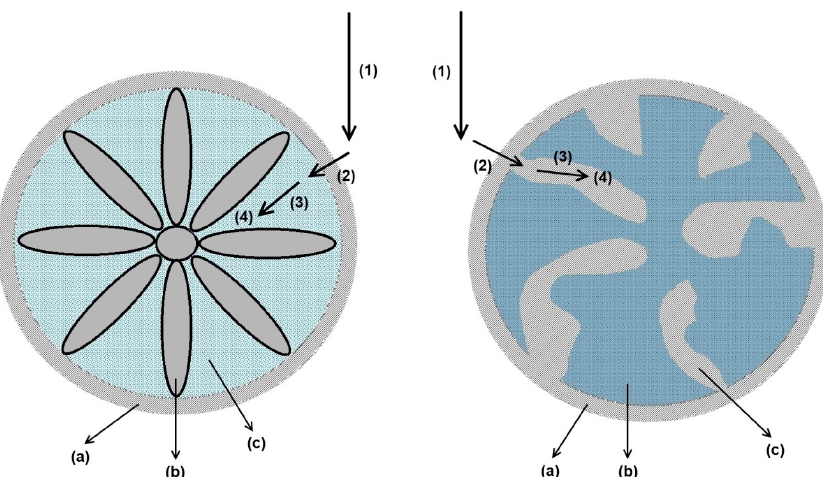
Figure 2. Comparision between mass-transport mechanisms for modified winged fibers ( left ); and porous resins ( right ). (1) Convective transport in mobile phase; (2) External film diffusion; (3) Hydrogel/Pore diffusion; (4) Adsorption. (a) External film; (b) Solid support matrix; (c) Hydrogel layer/Pore volume.